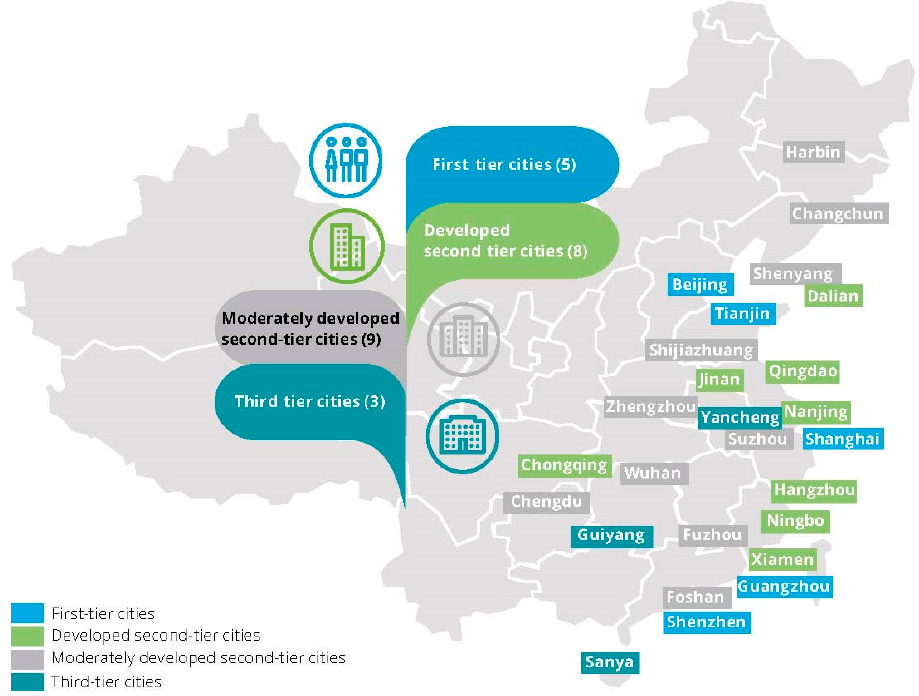
Figure 1. Distribution of smart city samples (source: zhihuichengshi.cn).